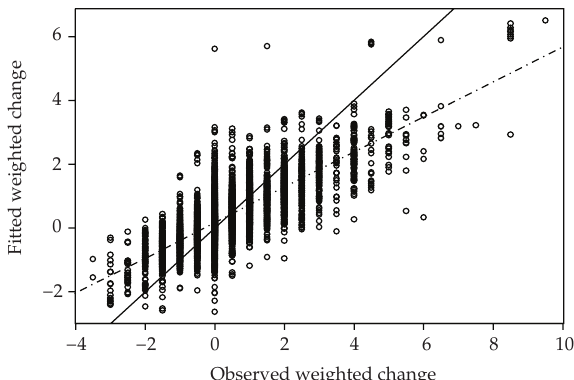
Figure 5: Plot of observed against fitted values (cid:3) dashed line: linear regression line of the scatter plot; full line: the diagonal (cid:4)